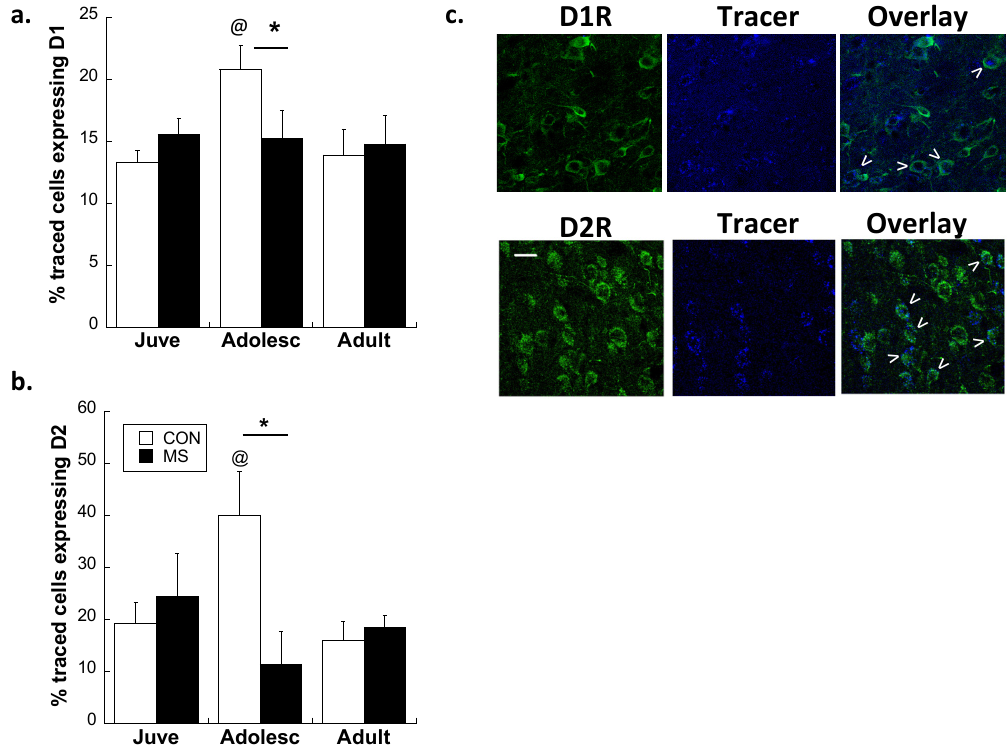
Figure 5. Peak D1R ( a ) and D2R ( b ) expression on PFC → NAc projections in adolescence is absent after MS. * p < 0.05 difference between stress groups using Bonferroni post-hoc t -tests after 2-way ANOVA. @ p < 0.05 difference from juveniles. White bars: CON; Black bars: MS. Averages ± SEM are presented. Representative photomicrographs from CON adolescent animals displaying receptor-ir, retrograde tracer, and colocalization (arrows) are shown in ( c ). Bar: 20 µm. Images cropped and enlarged for clarity. n = 6 for all treatment